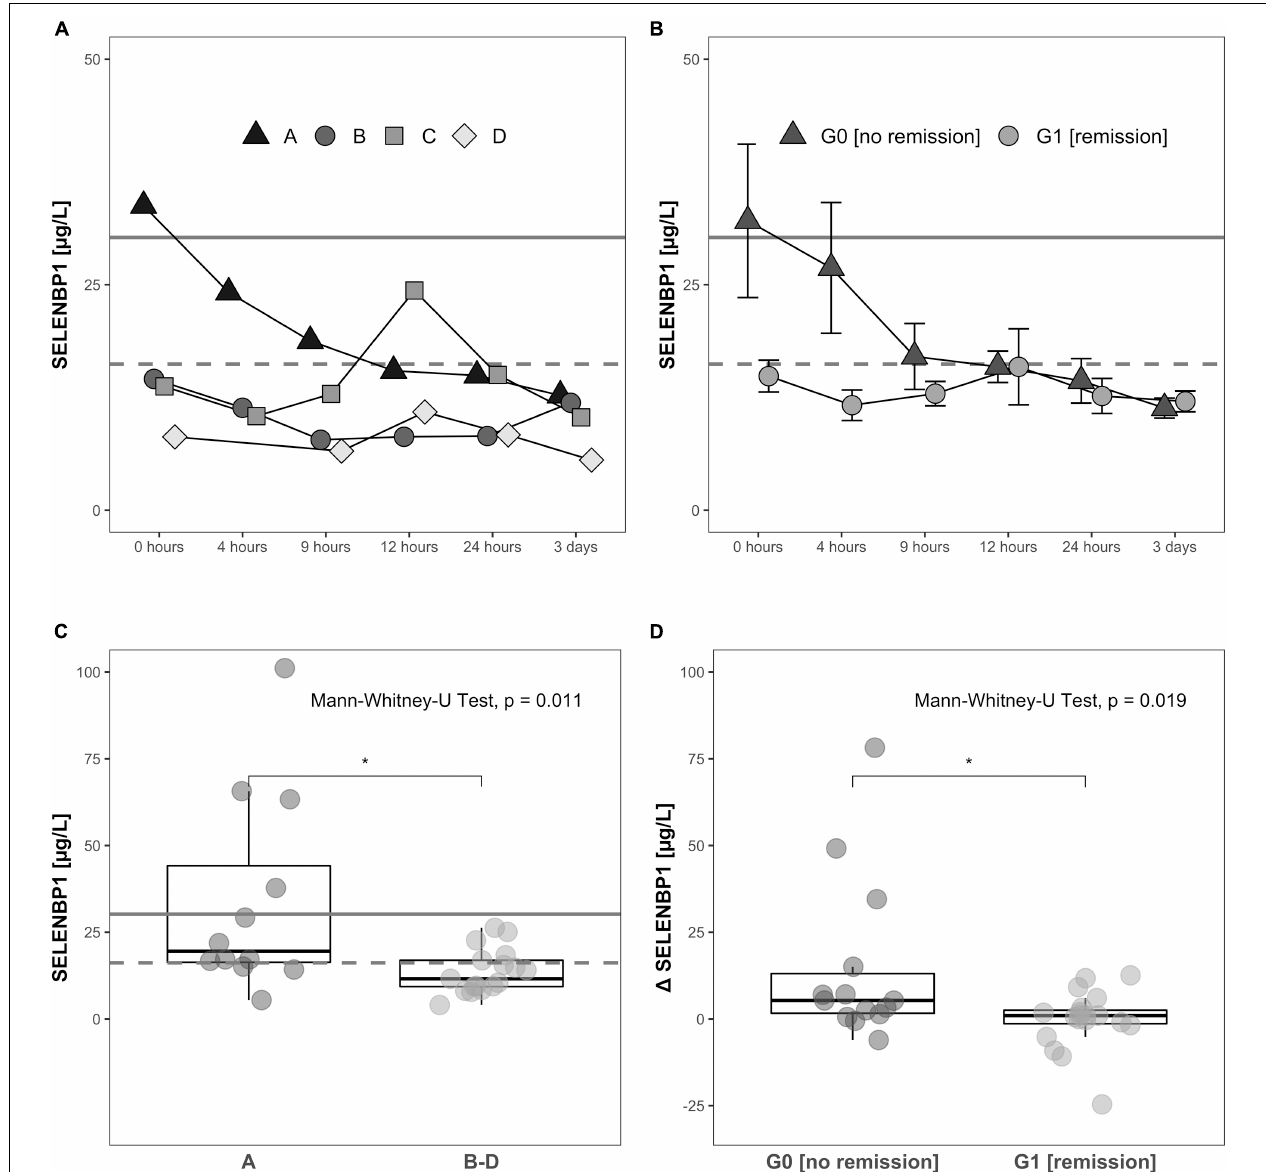
FIGURE 4 | Relation of serum SELENBP1 to the functional impairment at admission and neurological remission. Differences in SELENBP1 concentrations are shown as time-resolved line plots (A,B) or box plots (C,D) . The mean SELENBP1 levels (16.2 µ g/L) of the control group C are depicted as dashed line. Changes ( (cid:49) SELENBP1) were calculated by subtracting the late (12 h–3 day) from the early (0–12 h) SELENBP1 concentrations (D) . Serum SELENBP1 at hospital admission (0 h) was elevated in patients classified as A by the AIS scheme (most severe) in comparison to patients with a (B–D) rating (less severe) (A,C) . Similarly, serum SELENBP1 is particularly elevated during the first 3 days after injury in patients not undergoing remission (B,D) . The calculated cut-off (30.2 µ g/L) for the SELENBP1 threshold as a prognostic marker for remission is indicated as solid line. Values are expressed as mean ± SEM. The Mann-Whitney-U-Test assessed significant differences between two groups; * p <